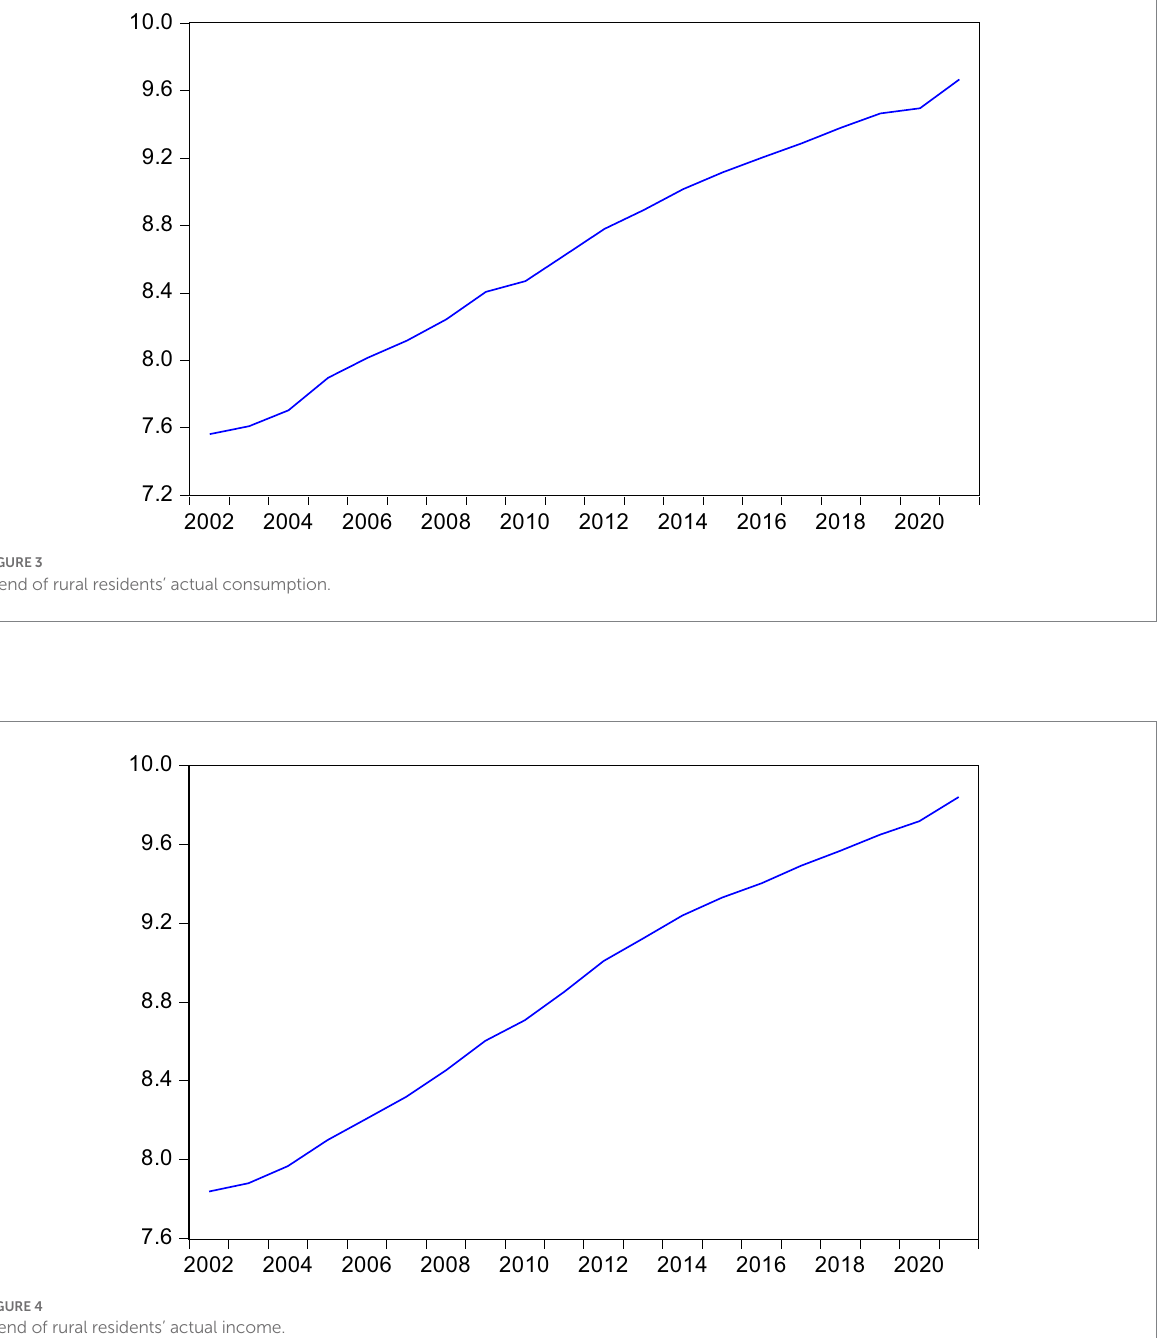
FIGURE 4 Trend of rural residents’ actual